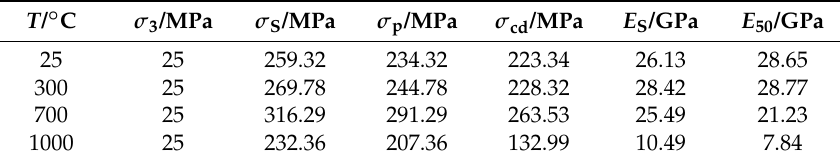
Table 1. Strength parameters of tested samples.